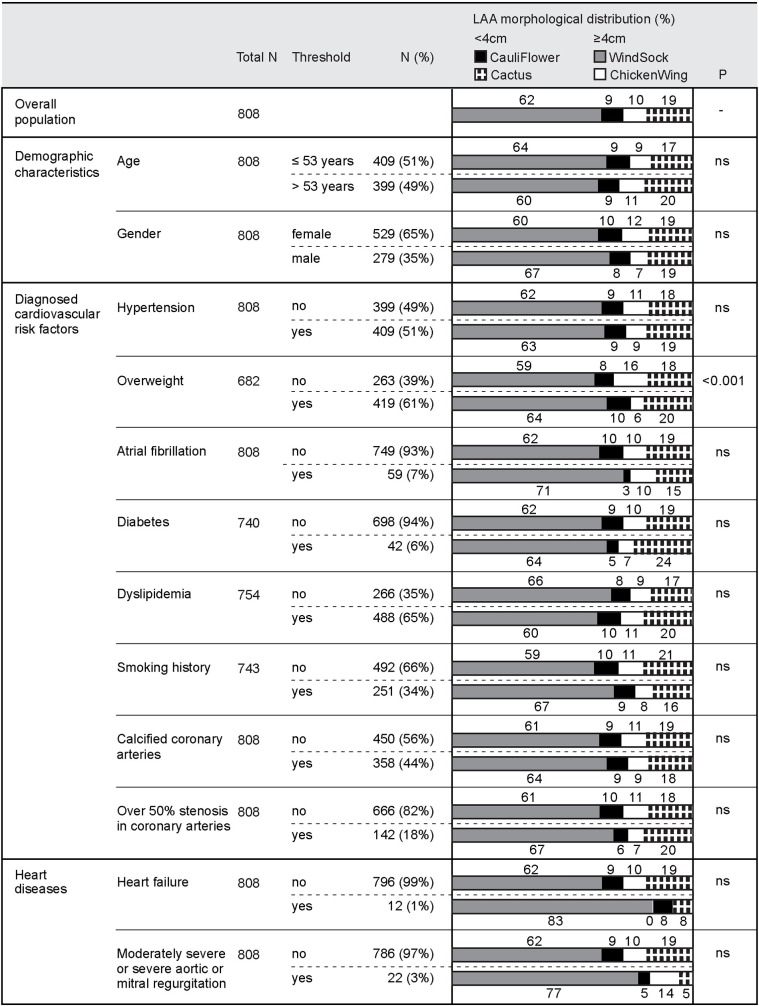
Correlates between morphological classes of the left atrial appendage and classification criteria.